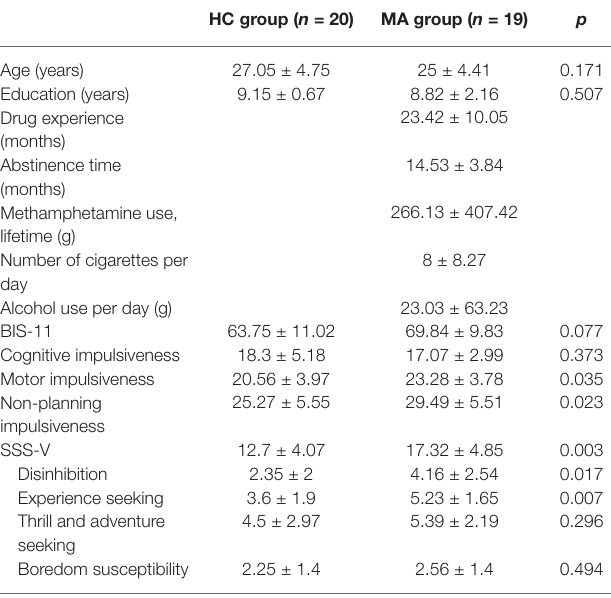
TABLE 1 | Sample characteristics ( M ±